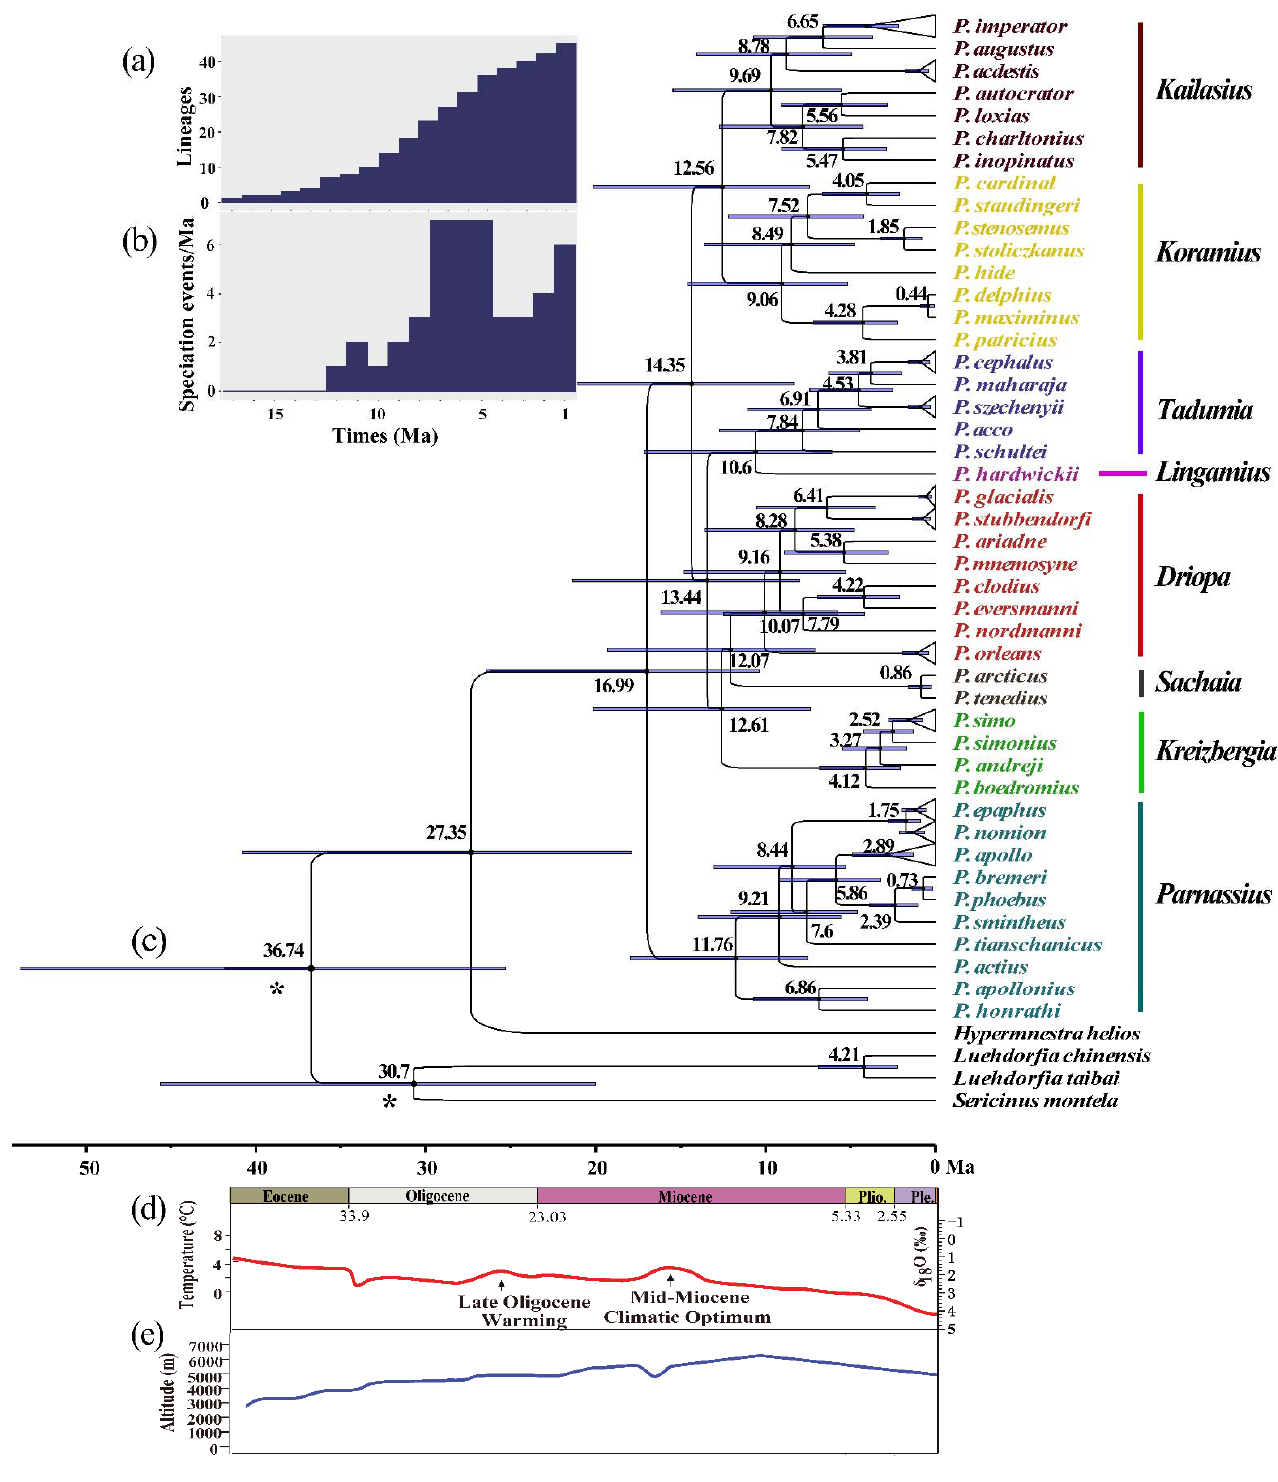
Figure 4. Estimated divergence dates and diversification rate of Parnassius and their association with geological and climatic events. ( a ) Lineage-through-time plot and 95% confidence intervals of lineage diversification. ( b ) Diversification rate per million years since the Early Miocene. The dashed line represents the rapid diversification events of Parnassius . ( c ) Divergence time estimates through BEAST, with 95% HPD intervals at the branches. * Indicates the calibration points. ( d ) Global temperature curve based on oxygen isotopes [4]. ( e ) Elevation curve of the Qinghai–Tibetan Plateau (QTP) since the Eocene [59].